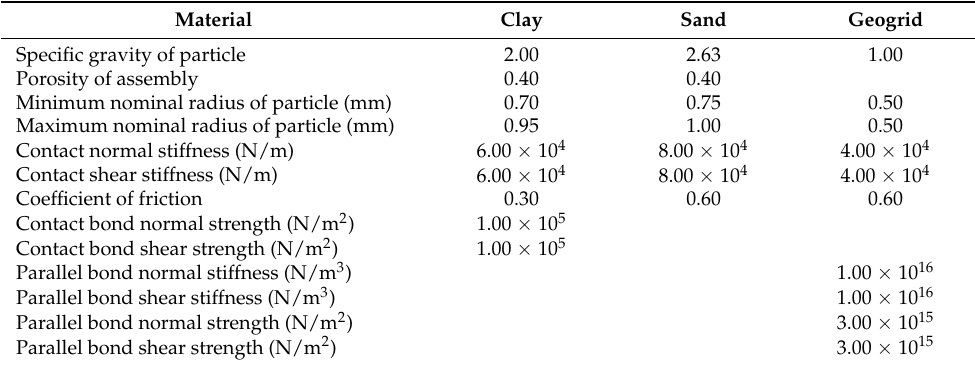
Table 1. The mesoparameters of the particle flow model.